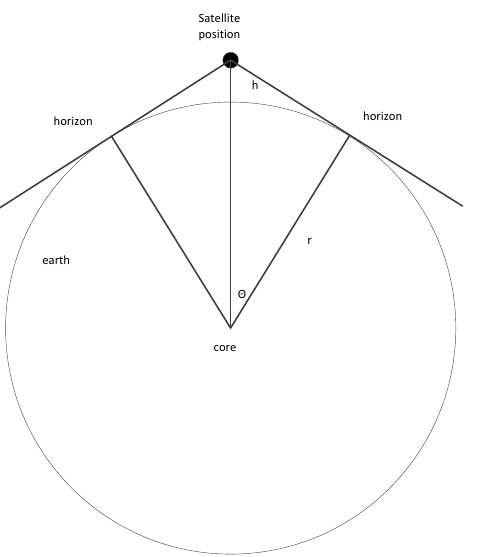
Figure 14. Schematic diagram of ascending intersection right ascension calculation.